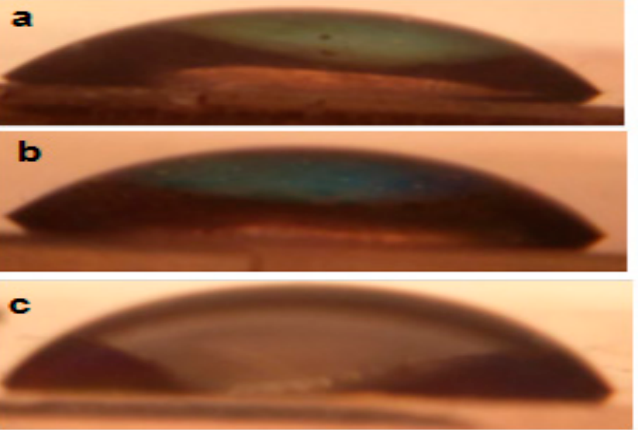
Figure 4. The contact angle of the as-deposited films at ( a ) 250 °C, ( b ) 350 °C, and ( c ) 450 °C.